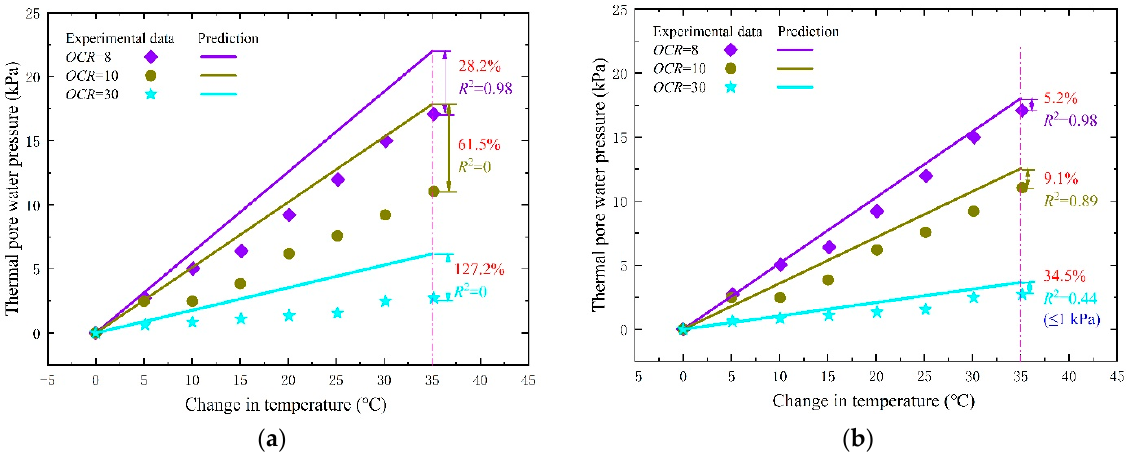
Figure 4. Comparison between experimental results and predicted results of ( a ) Case 1; ( b ) Case 2.